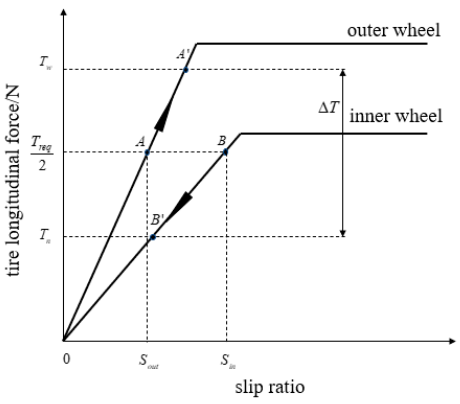
Figure 1. Longitudinal force characteristics of inner and outer driving wheels.